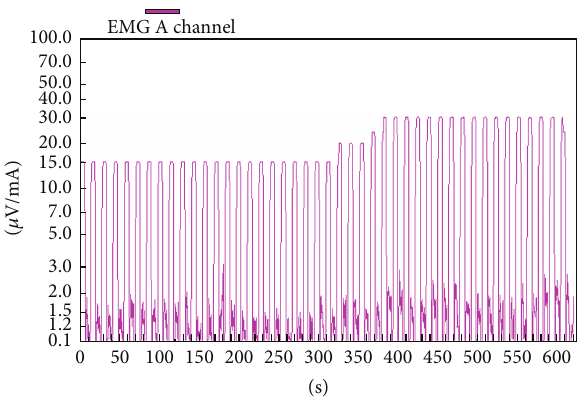
Figure 6: Electrical stimulation. Tracing of a patient with urge urinary incontinence associated with pelvic floor spams. Electrical stimulation mode serves to desensitize muscles to graded elevation of muscle stimuli. With the baseline set to 15 mcV/mA, a baseline electromyographic pelvic floor activity is seen. As the stimulation mode increases to 30 mcV/mA, the electrical activity does not increase, as it is